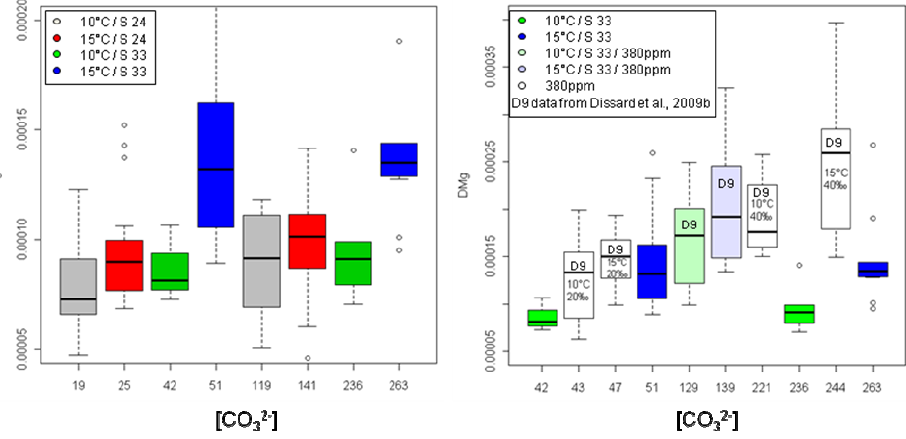
Fig. 5. Mg distribution coefficient (D(Mg)) versus [CO 2 − ] (µmolkg − 1 ) at 10 ◦ C, salinity 24 (grey); 15 ◦ C, salinity 24 (red); 10 ◦ C, salinity 3 33 (green); and 15 ◦ C, salinity 33 (blue) (a) ; and at 10 ◦ C, salinity 33 (green); 15 ◦ C, salinity 33 (blue); 10 ◦ C, salinity 33, 380ppmv (pale green); 15 ◦ C, salinity 33, 380ppmv (pale blue); 10 ◦ C, salinity 20, 380ppmv; 15 ◦ C salinity 20, 380ppmv; 10 ◦ C, salinity 40, 380ppmv, and 15 ◦ C salinity 40, 380ppmv (white) (b) . Data for ambient atmospheric conditions (380ppmv, labelled D9) are from Dissard et al. (2009b). The first to third quartile (box), range (dotted line) and median (thick line) are shown for each experiment.